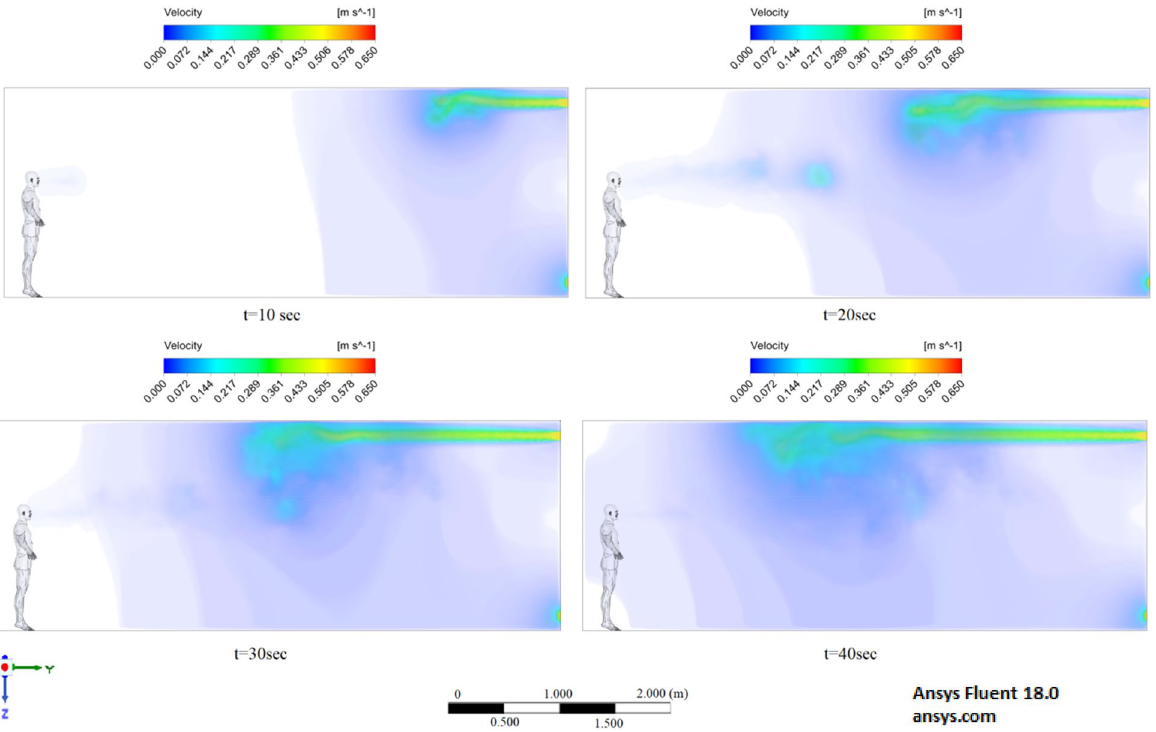
Figure 14. Velocity contours for cough = 20 m/s and ventilation = 0.5